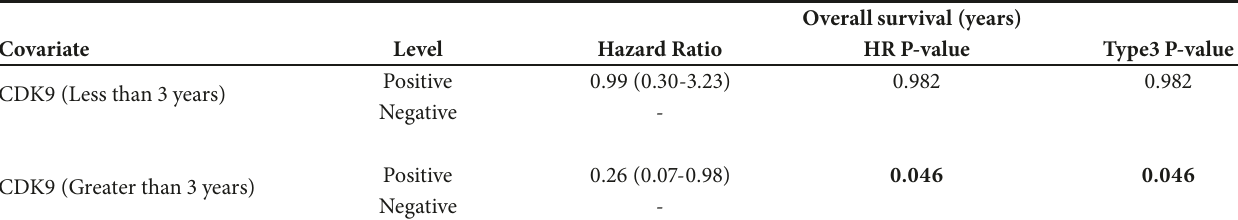
Table 2: O verall survival- 3 y ears . This table shows an increase in overall survival after 3 years with tumors positive for CDK9 as compared to those negative for CDK9.